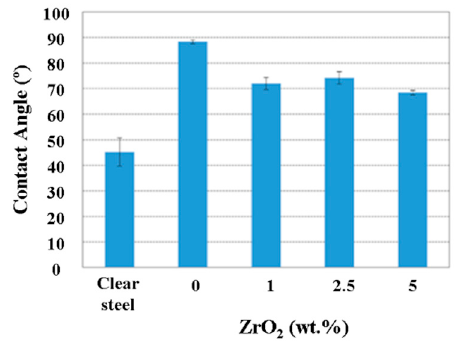
Figure 7. Contact angle of coatings with different liquids as a function of zirconia percentage added .